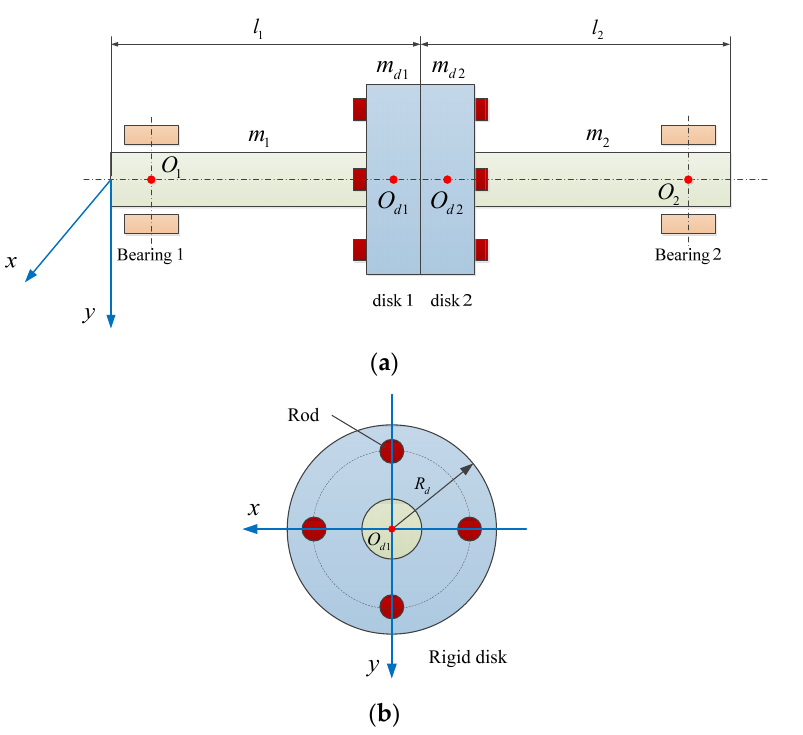
Figure 3. The schematic drawing of the rod-fastened rotor system supported by two- and three- axial-groove gas bearings: ( a ) schematic drawing of the rod-fastened rotor; ( b ) the circumferential distribution of rods.